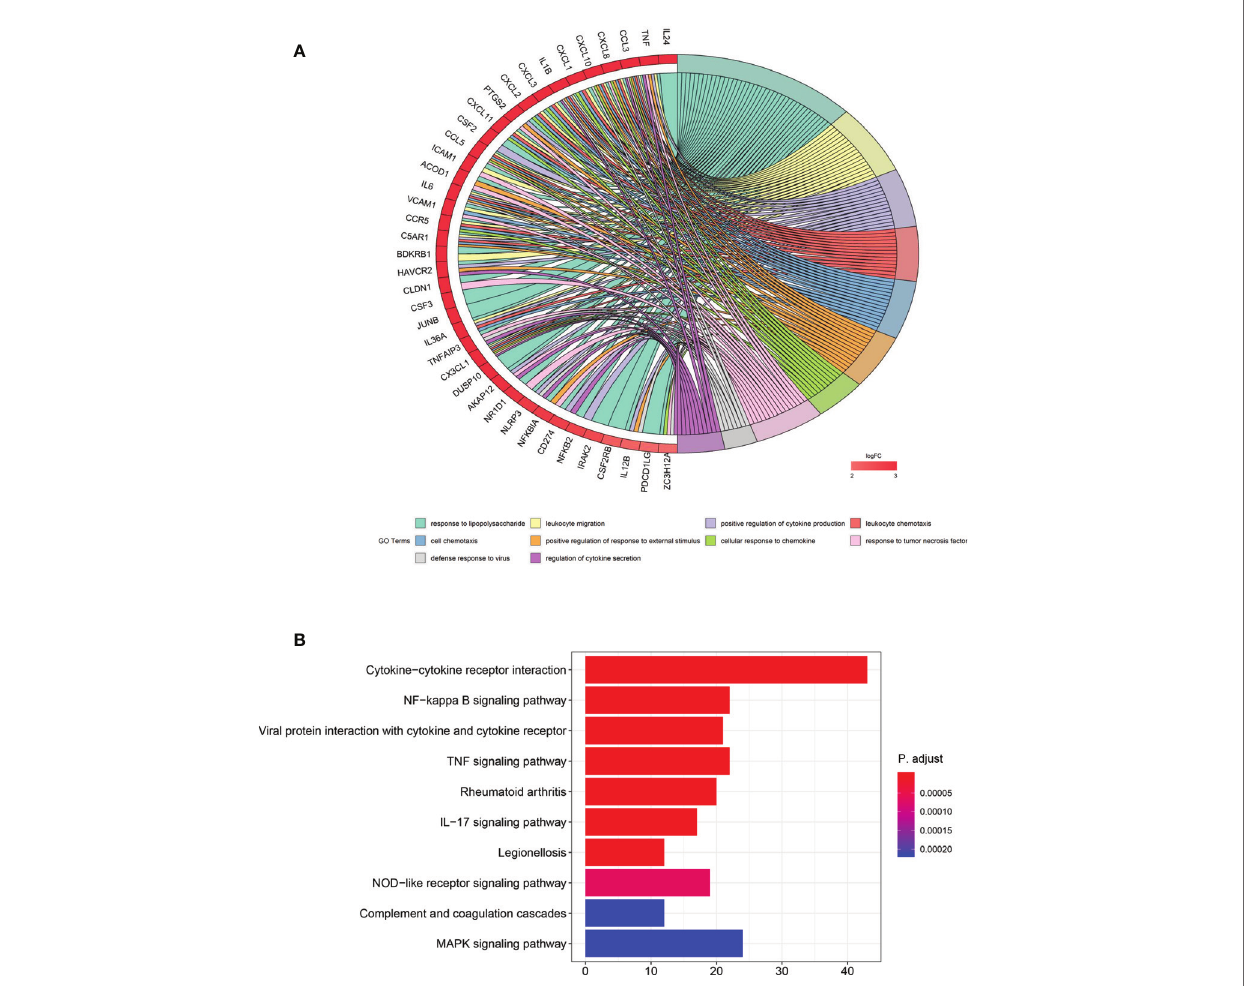
FIGURE 4 | Overexpression of ITM2A induced immunity related response. (A) DEGs were derived based on RNA-seq data on MCF-7 cells that overexpressed ITM2A. Then the DEGs were mapped to GO terms and the top 10 ranked GO terms are showed. (B) The top-10 ranked KEGG pathways in which DEGs enriched. DEGs, differentially expressed genes; RNA-seq, RNA-sequencing; GO, gene